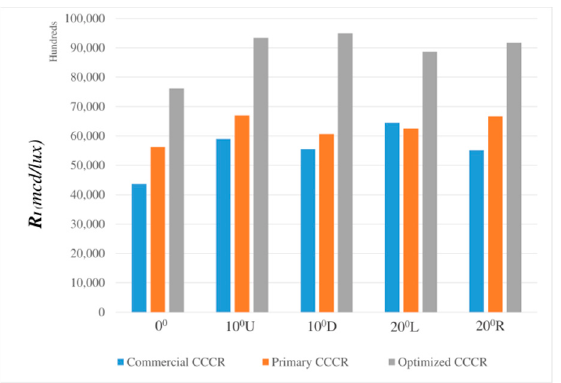
Figure 23. Comparison of reflection coefficient R I of commercial CCCR, primary CCCR, and optimized